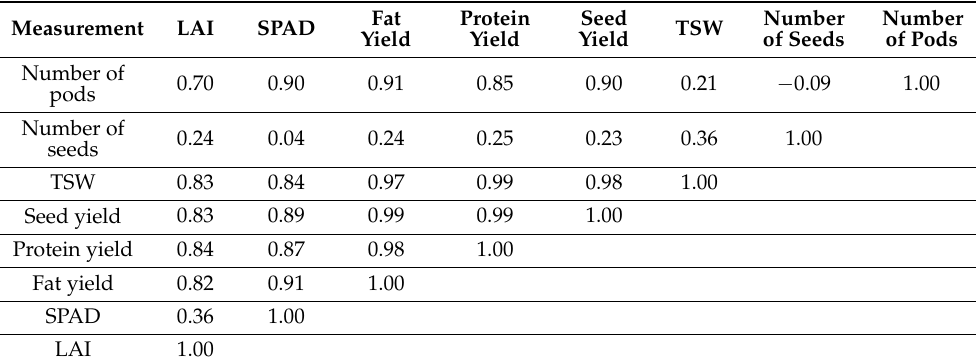
Table 6. Correlation between selected